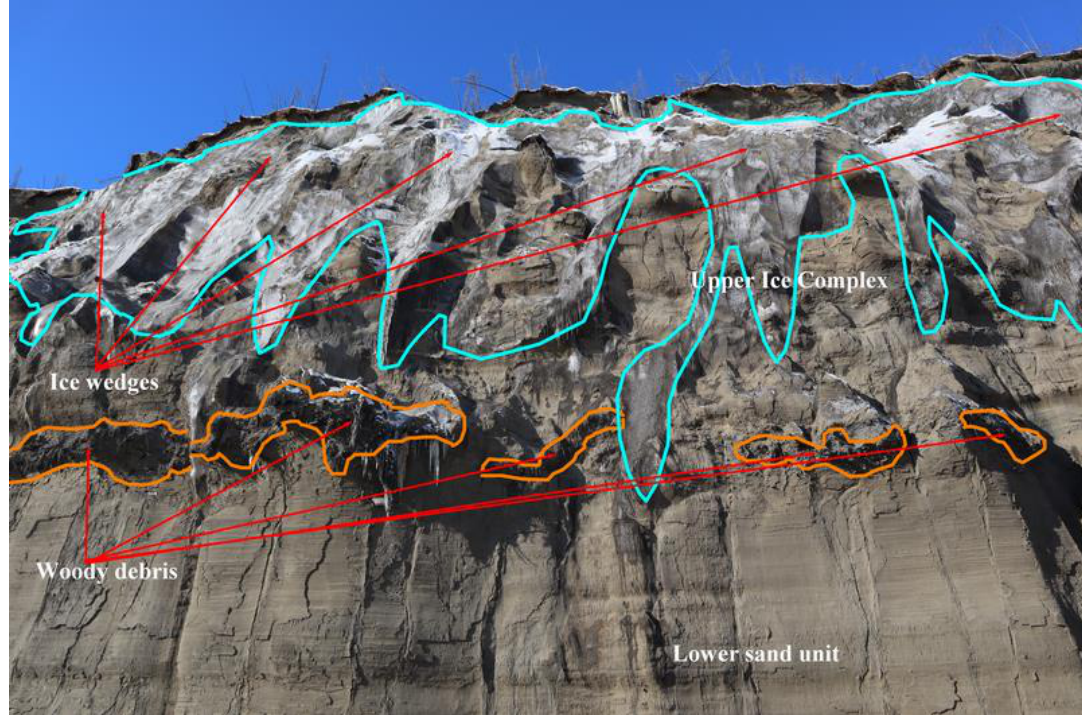
Figure 3. The upper Ice Complex unit overlying the woody bed (orange line) and the lower sand unit.